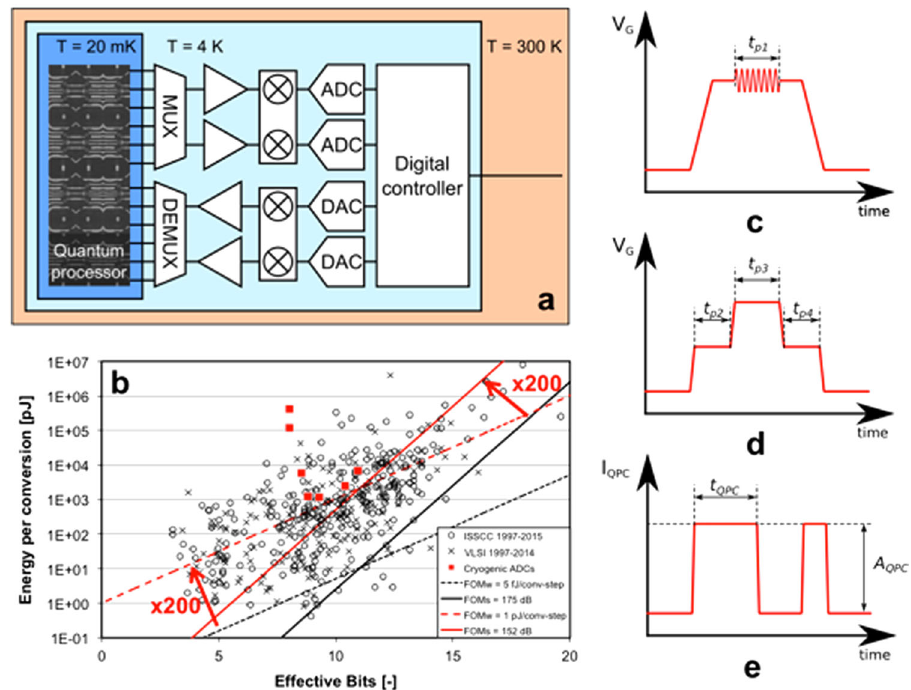
Fig. 3 Classical circuitry for qubit control and electrical signals typically used to perform operation and read out of three electron spin qubits. 36, 75 a Generic fault-tolerant interrogation correction loop, comprising both an analog front-end and a digital back-end. b Energy ef fi ciency of state-of-the-art room-temperature CMOS ADCs and cryogenic CMOS ADCs. 76 The energy spent by an ADC for a single conversion, i.e., E C = P / f s , where P is the power consumption and f s the sampling frequency, strongly depends on its resolution, i.e., the number of effective bits N. Consequently, ADC energy ef fi ciency is quanti fi ed by the Schreier Figure-of-Merit (FOMs = 10 log10 [2N f s /(2 P )]) for high- resolution thermal-noise-limited ADCs and by the Walden FOM (FOMw = P / f s /2N) for low-resolution ADCs. In terms of those FOMs, the energy ef fi ciency of existing cryogenic ADCs is 200× worse than state-of-the-art room temperature ADCs (FOMs = 175 dB, FOMw = 5 fJ/conversion step), due to the use of past node technologies and the unavailability of reliable cryogenic models for CMOS devices. c , d Voltage applied to the qubit gates to perform single-qubit rotations; typical waveform parameters: t p 1 ~5 – 20 ns, t p 1 , t p 2 , t p 3 ~100 – 500 ps, microwave